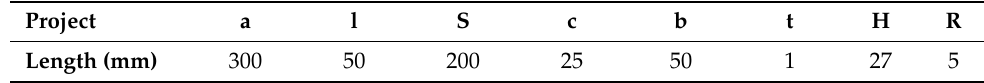
Figure 1. Schematic of the aluminum foam sandwich and the loading rolls. Table 2. Size of the aluminum foam sandwich samples.